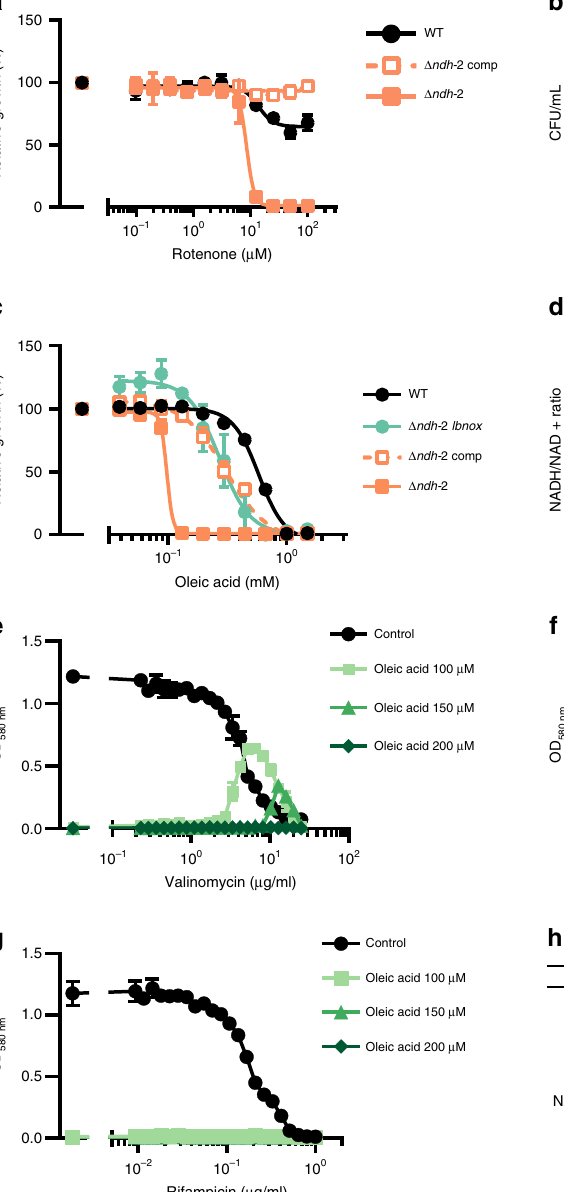
yet inactive against WT and Δ ndh-2 (Fig. 6F, Supplementary Figs. 14O and 15E, F) in fatty-acid-free media. Chemical and genetic inhibition of NDH-2 thus lead to similar phenotypes. Interestingly, both 2-mercapto-quinazolinones were also more active against Δ cydABDC than WT, which suggests that the inactivation of both cytochrome bd oxidase and NDH-2 synergize to inhibit Mtb ’ s growth (Supplementary Fig. 14E, F). The effect of